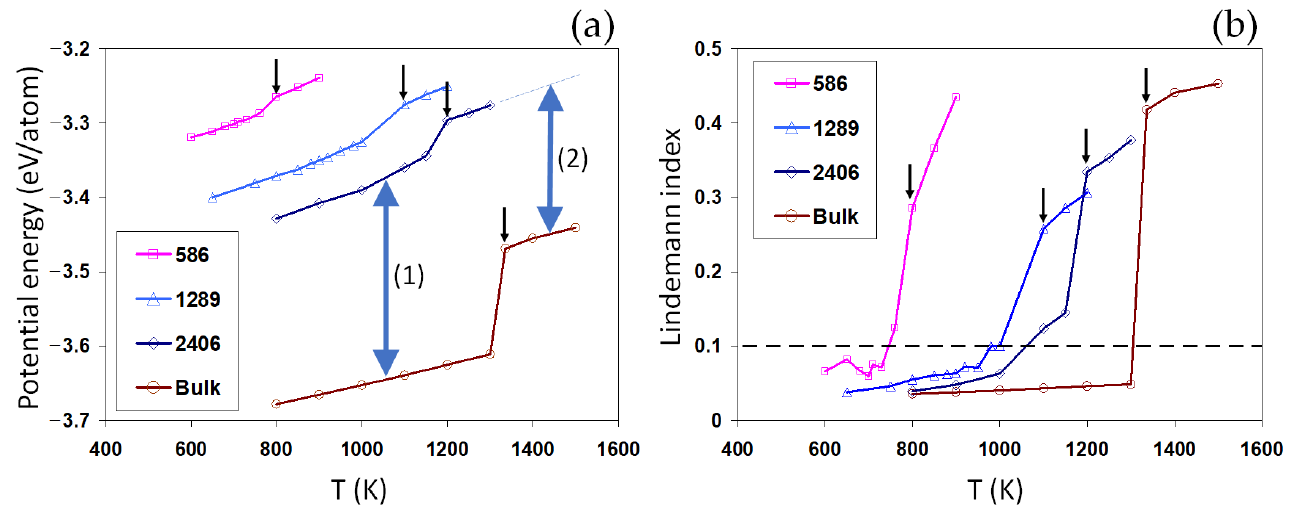
Figure 2. Melting of single nanoparticles. The potential energy ( a ) and the LI ( b ) of Au nanoparticles of different size and the reference bulk system are shown over temperature. Small arrows indicate the approximated melting point for each system. The two-sided arrow (1) and (2) indicates the increase in the overall potential energy for the solid and liquid nanoparticle, respectively.